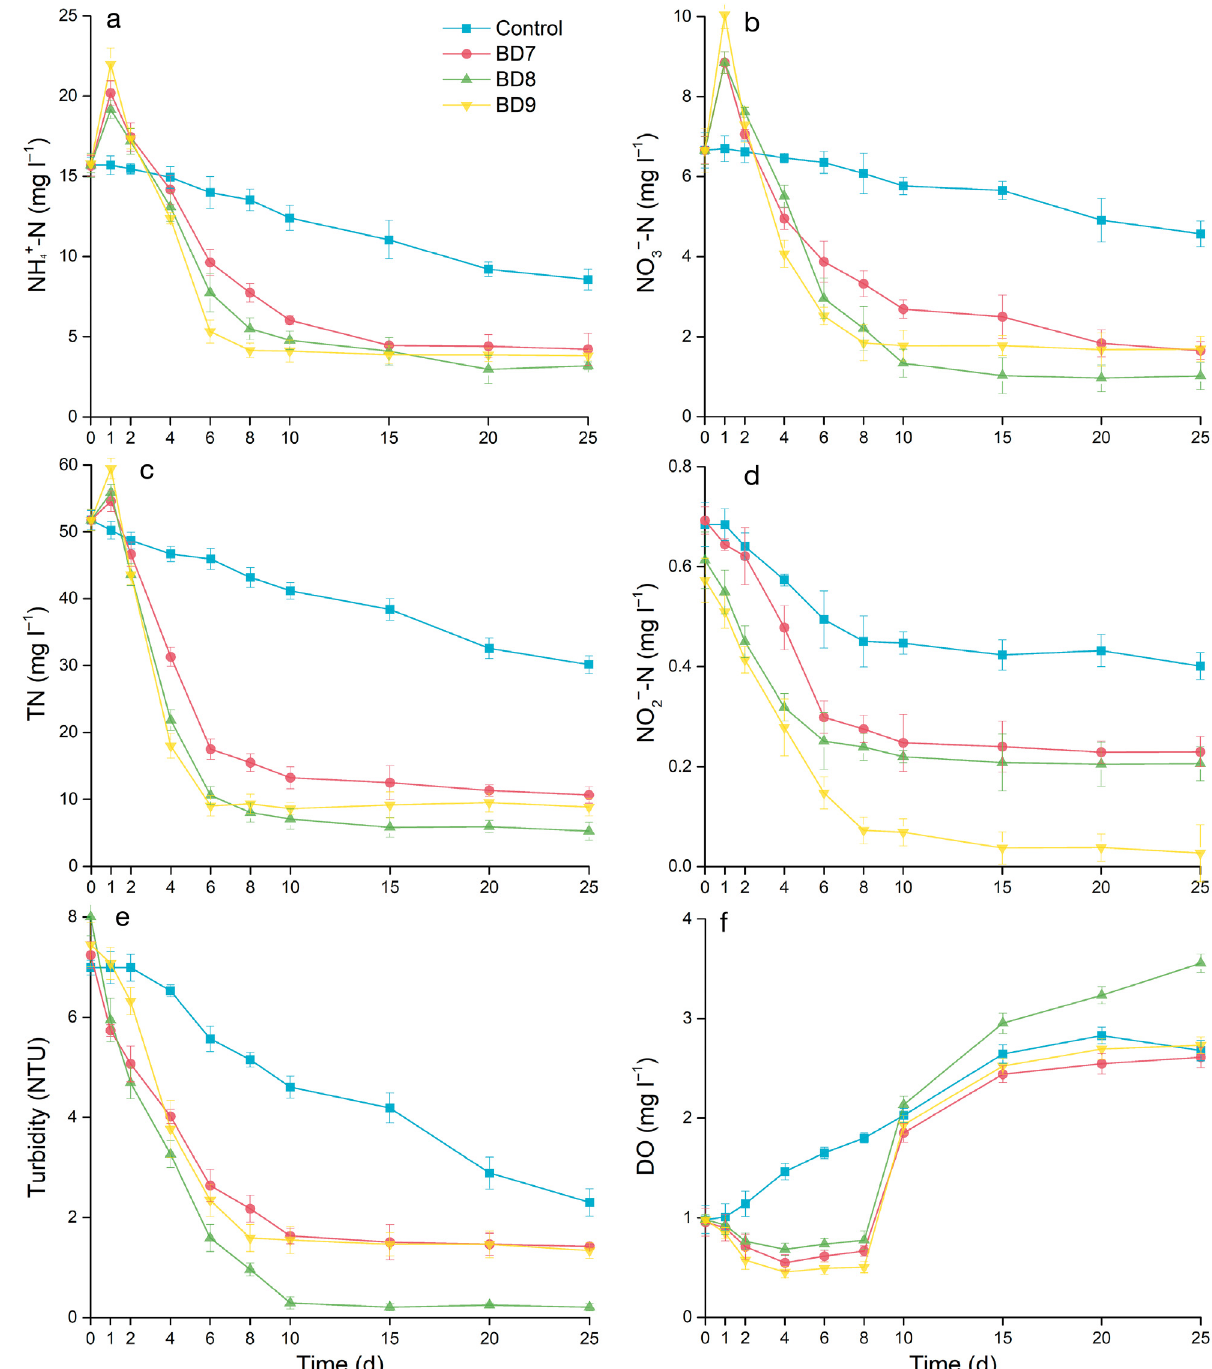
Fig. 1. (a) NH 4+ -N, (b) NO 3− -N, (c) total nitrogen (TN), (d) NO 2− -N, (e) turbidity and (f) dissolved oxygen (DO) variation curves under different treatments. Vertical bars represent ±SD of the means (n = 3). BD7/BD8/BD9: inoculation levels of Bacillus subtilis D9 at 5.5 × 10 7 / 5.5 × 10 8 / 5.5 × 10 9 cfu ml